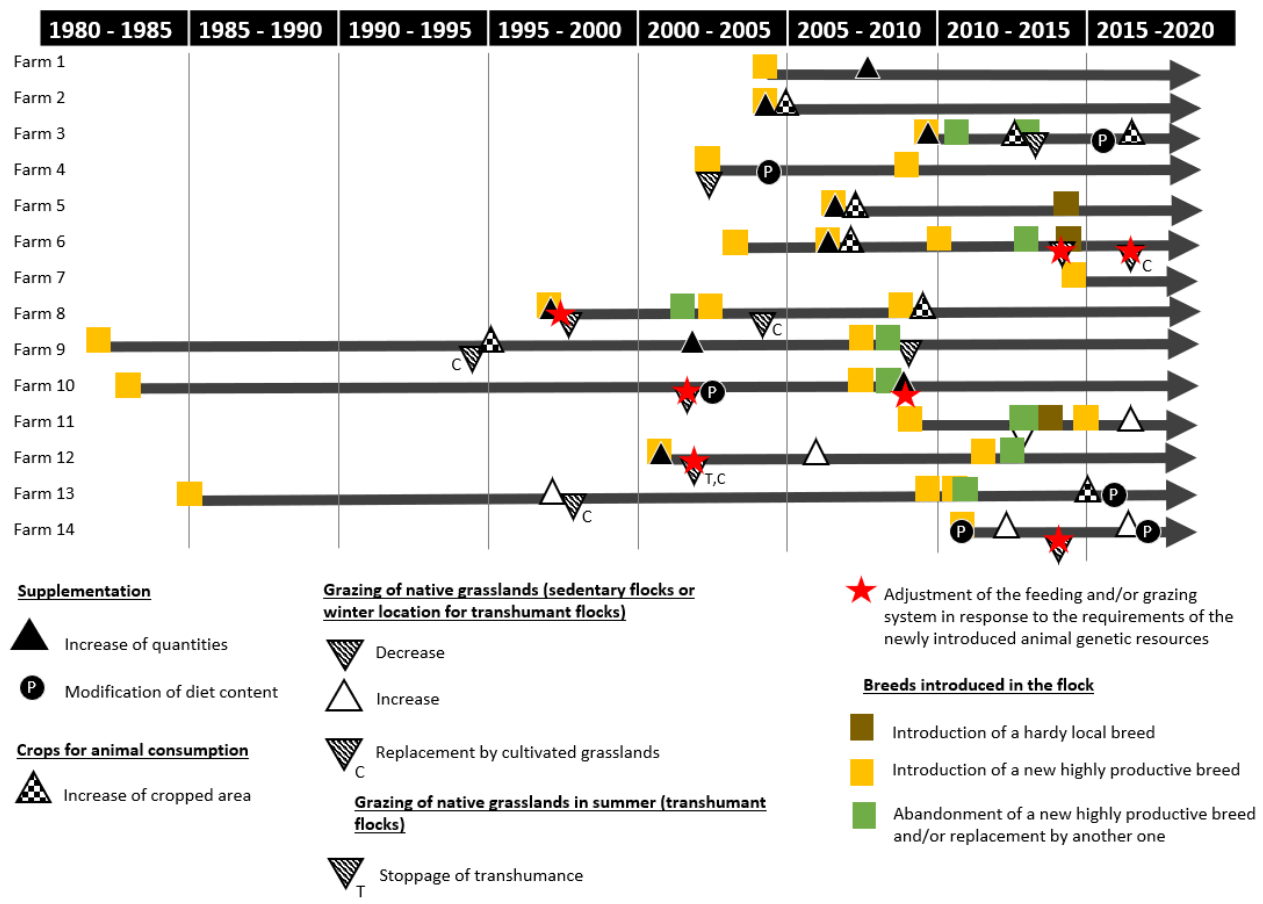
Figure 1. Comparative evolution of the flocks’ breed compositions as well as the feeding and grazing systems in 14 dairy sheep farms in Thessaly,